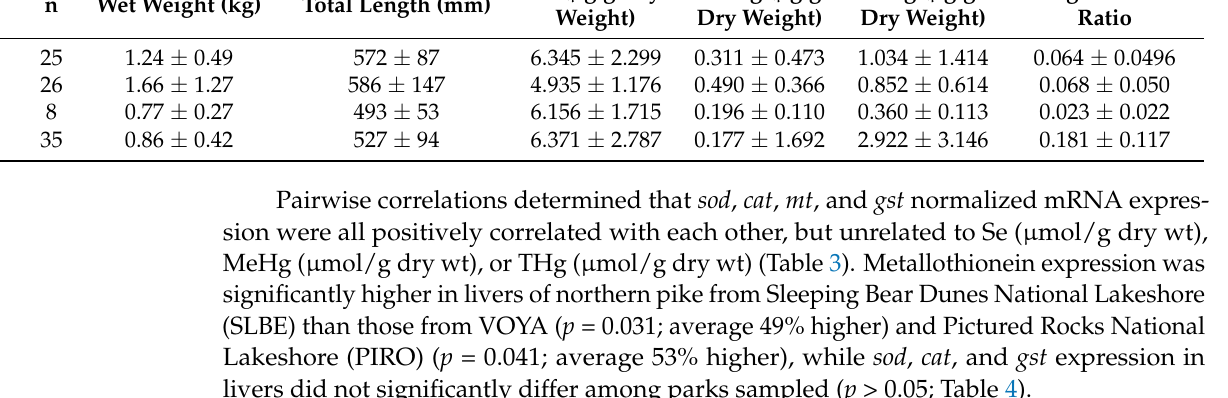
Table 3. Spearman correlation for gene expression and selenium (Se), methylmercury (MeHg), and total mercury (THg) in northern pike. The p -value of the test is presented in parentheses.